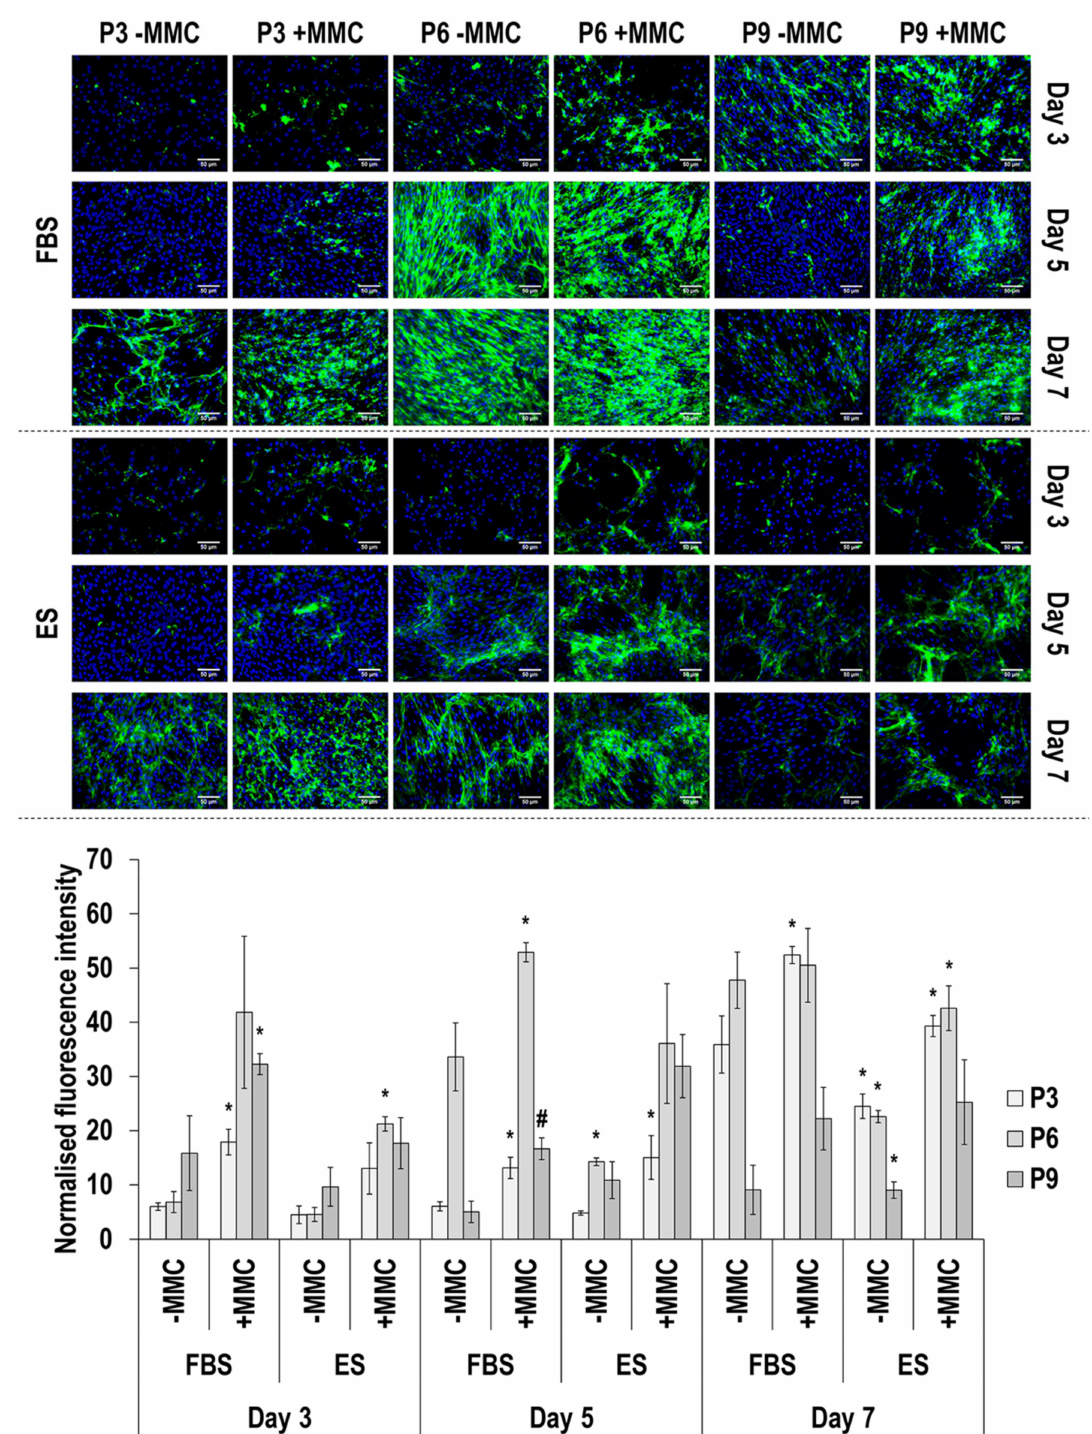
Figure 6. Immunofluorescence and image intensity analysis for collagen type VI as a function of serum, passage, MMC and time in culture. Fluorescence intensity was normalised to cell number. * indicates a significant ( p < 0.05) increase in comparison to cells at passage 3, day 3, in FBS and without MMC. # indicates a significant ( p < 0.05) decrease in comparison to cells at passage 3, day 3, in FBS and without MMC. Scale bar: 50 µ